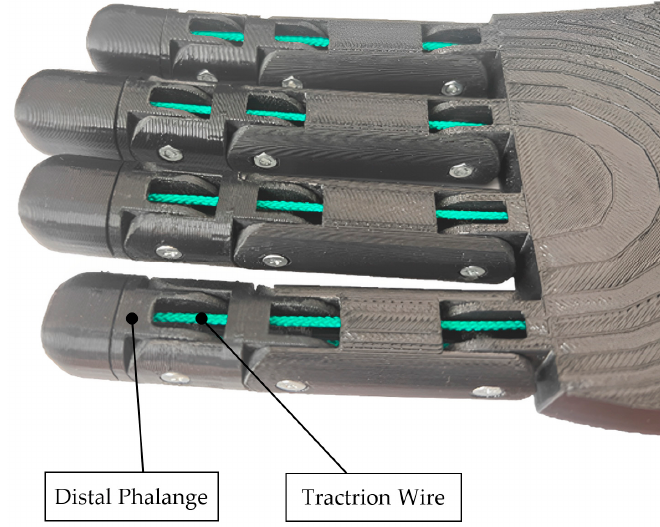
Figure 3. Wire mechanism of the prosthesis fingers.